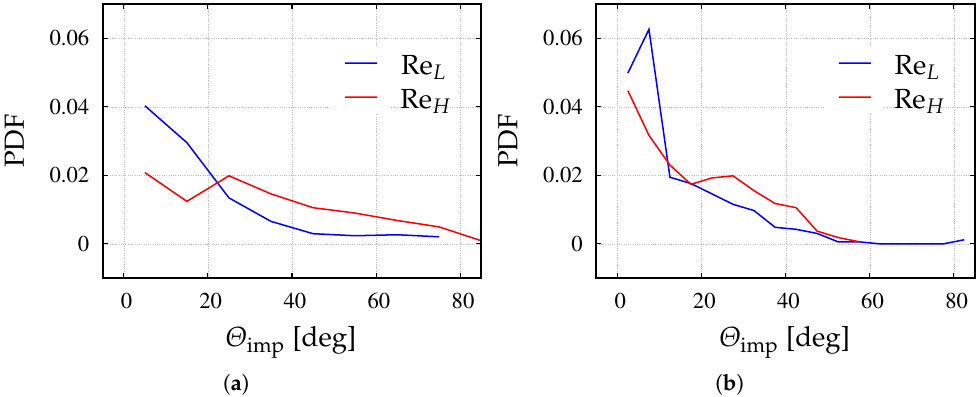
Figure 17. PDF of the impact angles Θ imp associated with the breakage events of the initial agglomer- ates comprising N tot p = 1200 particles. ( a ) 90 ◦ pipe bend. ( b ) 45 ◦ pipe bend.